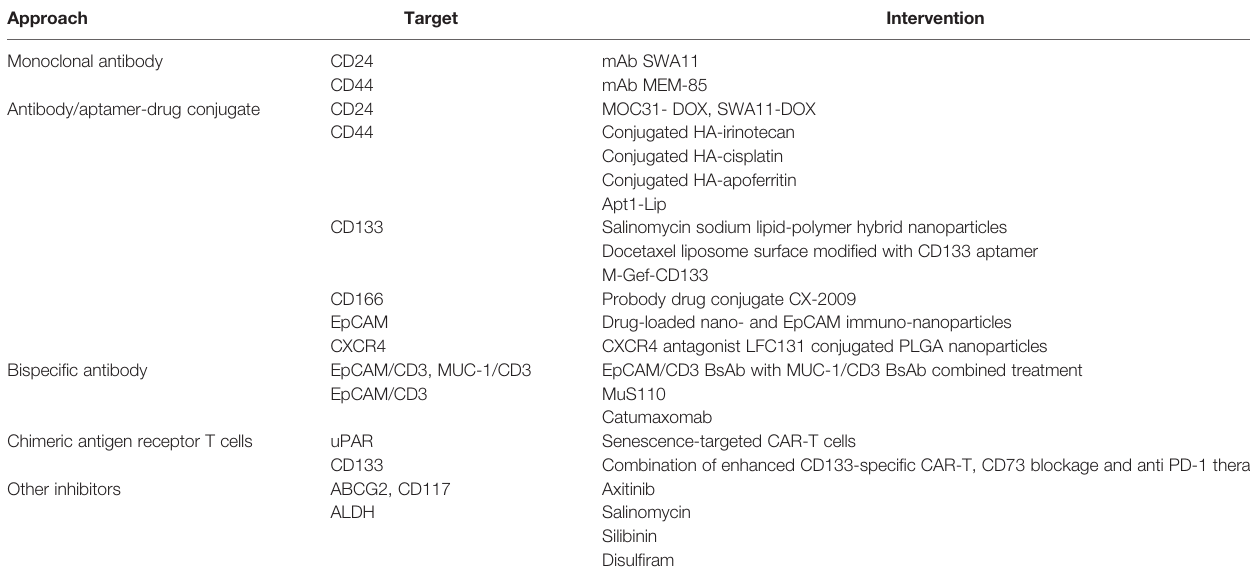
TABLE 4 | Potential therapies targeting lung cancer stem cell markers.